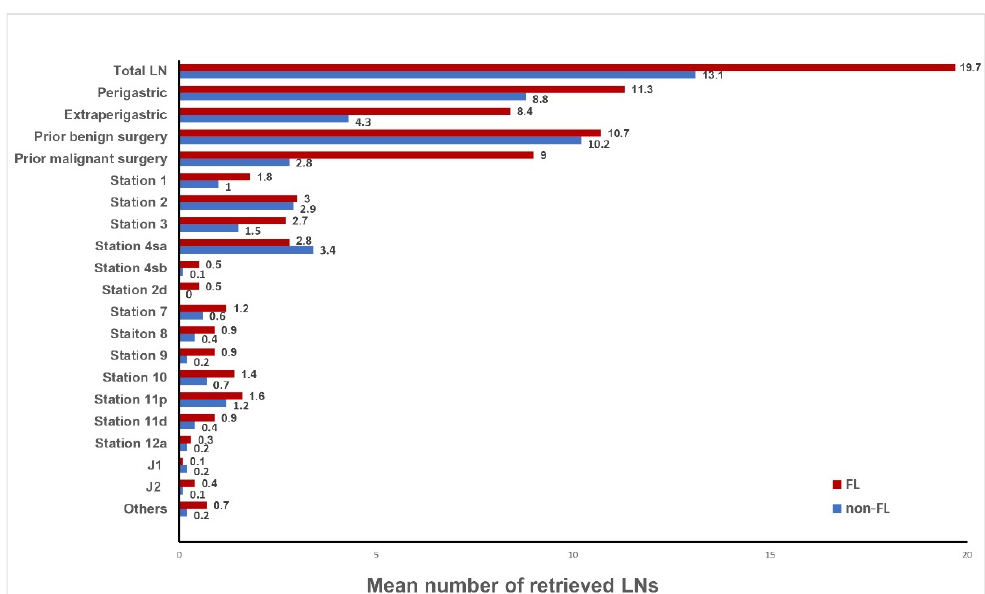
Figure 2. Mean number of retrieved lymph nodes.